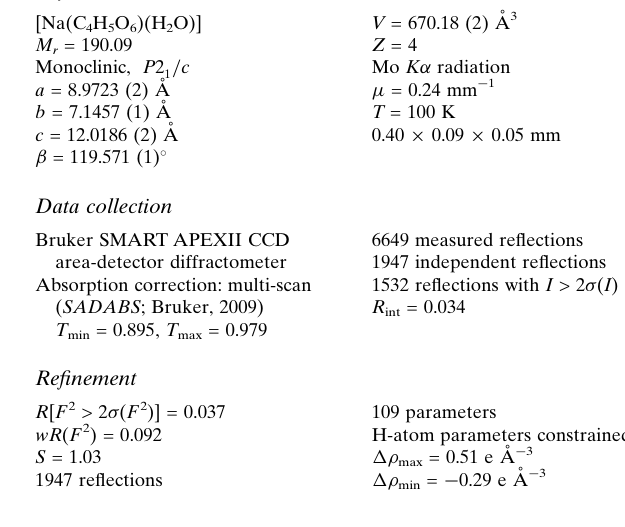
pentagonal–bipyramidal